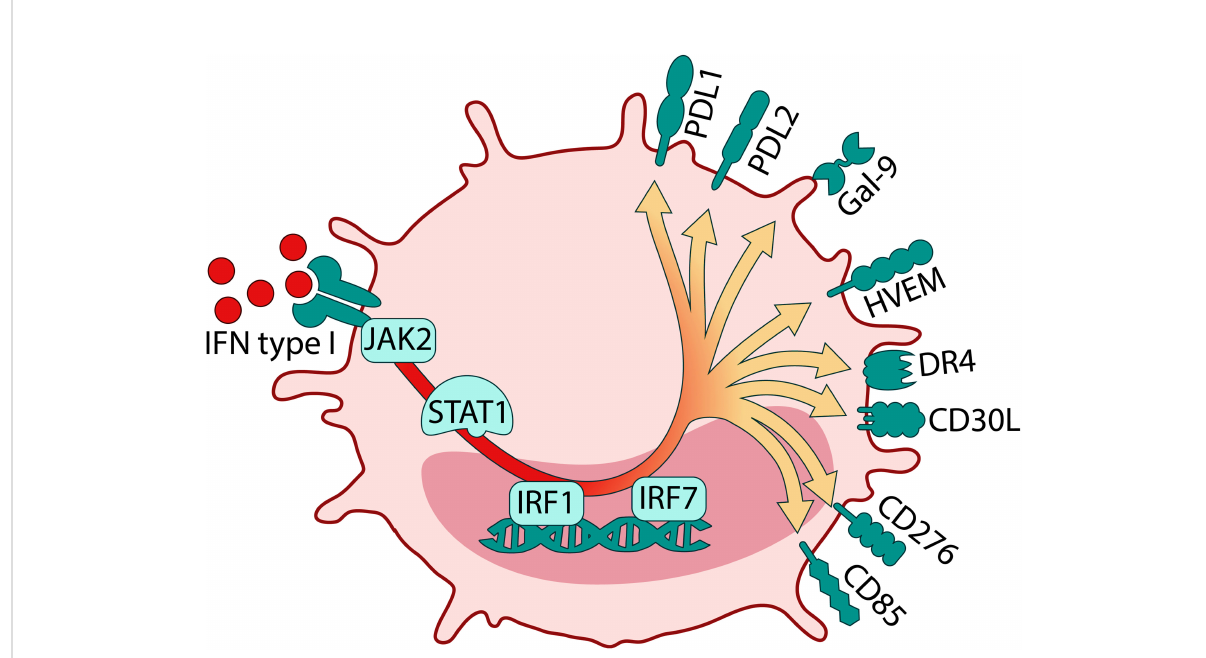
FIGURE 10 Graphical summary of HIV induced Tolerogenic DCs from DC T cell coculture. The crosstalk between DCs and T cells in the presence of HIV induces DCs with a tolerogenic phenotype and a strong type I IFN transcriptome pro fi